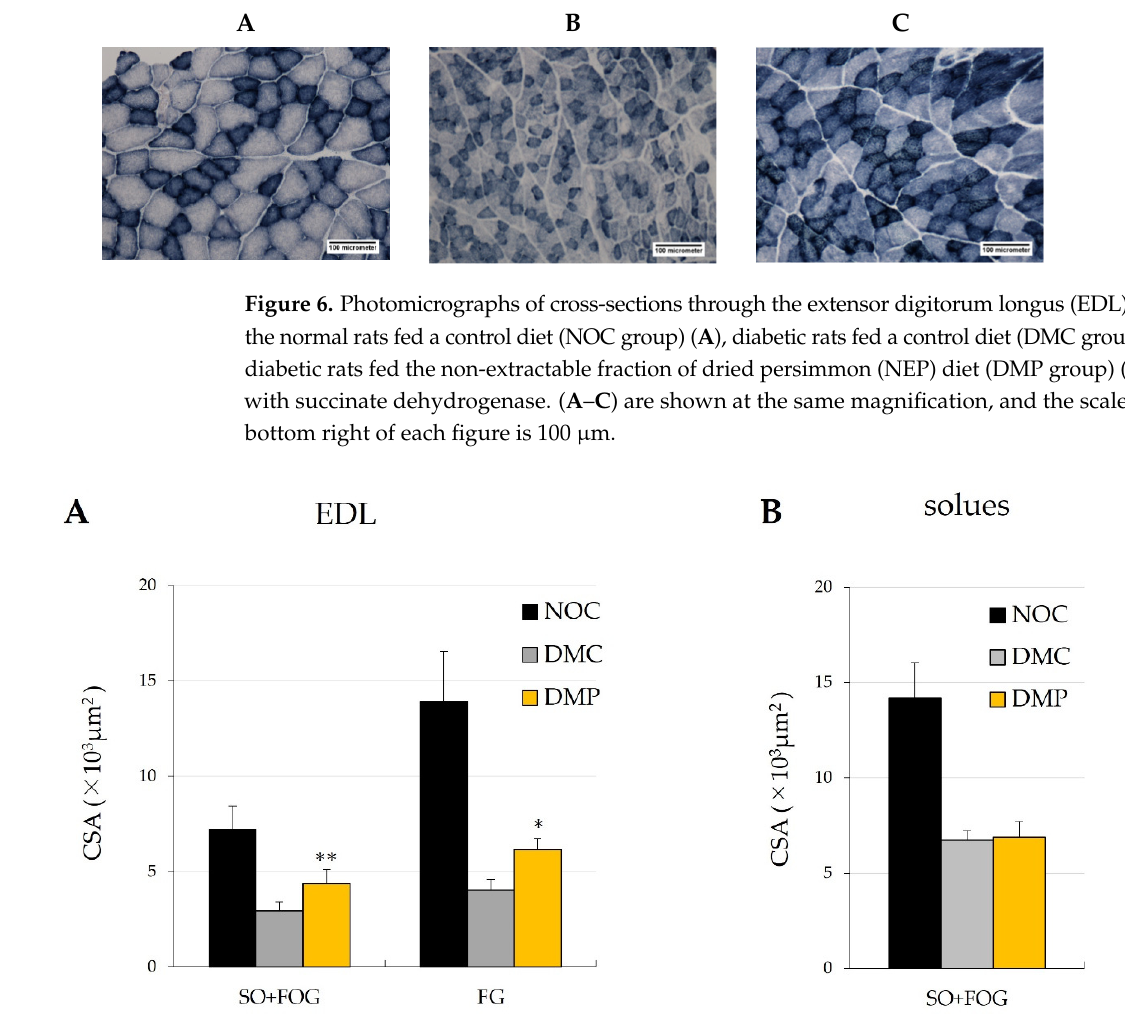
10 of 15 Figure 5. Effects of non-extractable fraction of dried persimmon (NEP) on the GSH/GSSG ratio ( A ), total glutathione concentrations ( B ), GSH concentrations ( C ), and GSSG concentrations ( D ) in liver tissues of normal and diabetic rats. NOC: normal rats fed a control diet, DMC: diabetic rats fed a control diet, DMP: diabetic rats fed NEP diet. Data are presented as the means ± SD of each animal in each group. * p < 0.05 significantly different from the NOC and DMC groups. 3.4. Effects of NEP on the Characterization of EDL and Soleus Muscle Fibers Photomicrographs of cross-sections through the EDL muscle of each group stained with SDH are shown in Figure 6. The effects of NEP on the CSA of EDL and soleus muscle fibers in each group are shown in Figure 7. EDL muscle fibers were smaller in the DMC group than in the NOC group (Figure 6A,B); however, the EDL muscle in the DMP group